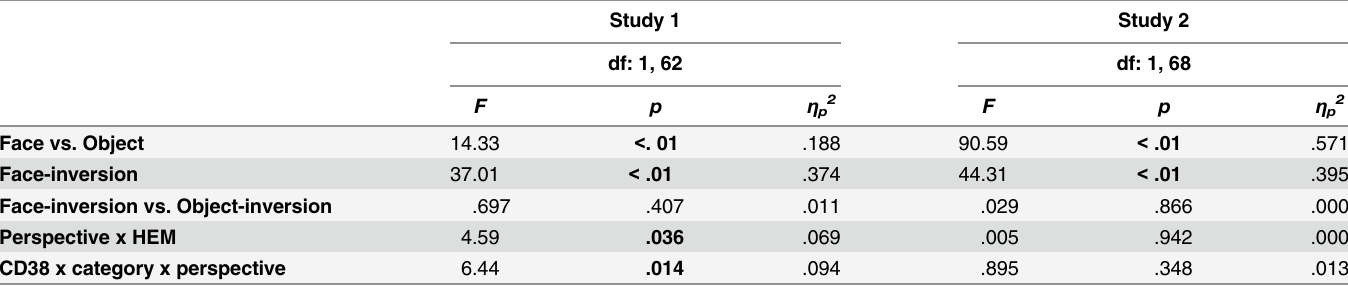
Table 4. Results of ANOVAs with repeated measurements regarding N170-latencies in reaction to upright and inverted neutral faces, and objects (chairs); Hemisphere (HEM), perspective (upright vs. inverted picture), CD38-SNP rs379863 (CD38); category (faces/chairs). Study 1 Study